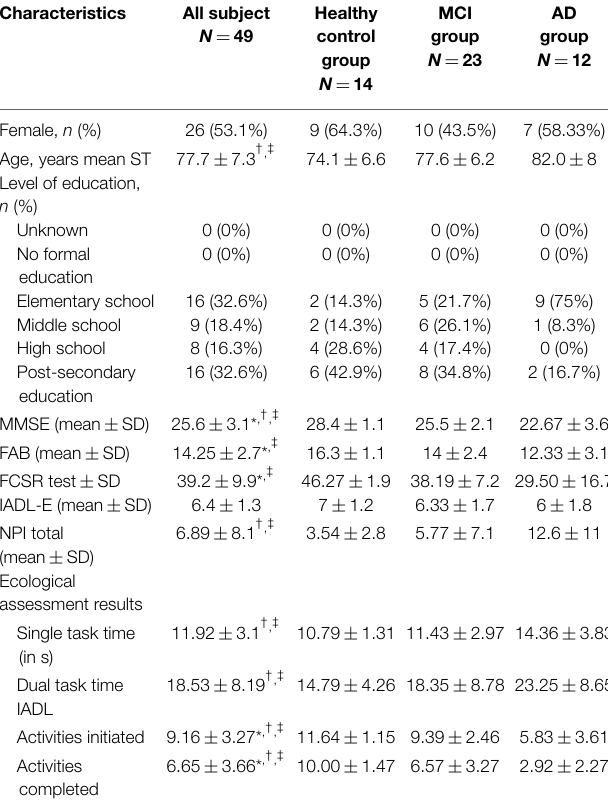
TABLE 2 | Characteristics and group comparisons for HC, MCI, and AD subjects